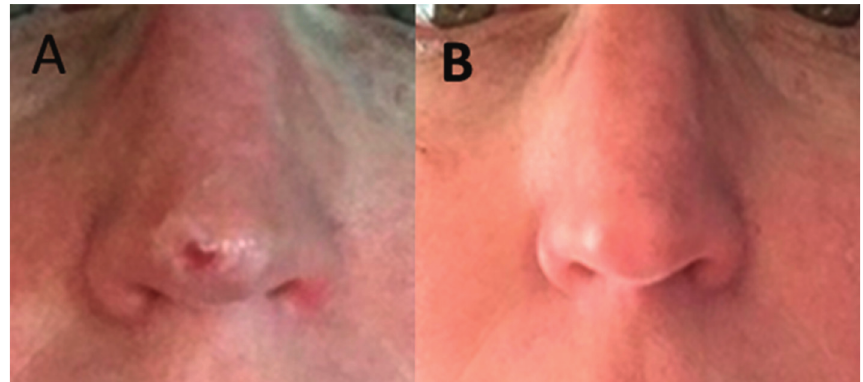
Figure 1: Three years prior to the present illness, the primary lesion of the right nasal tip was confirmed as BCC (a) through a shave biopsy on 1/24/2017. Approximately a month later in February (b), the wound was healed, and the patient was started on a full course of